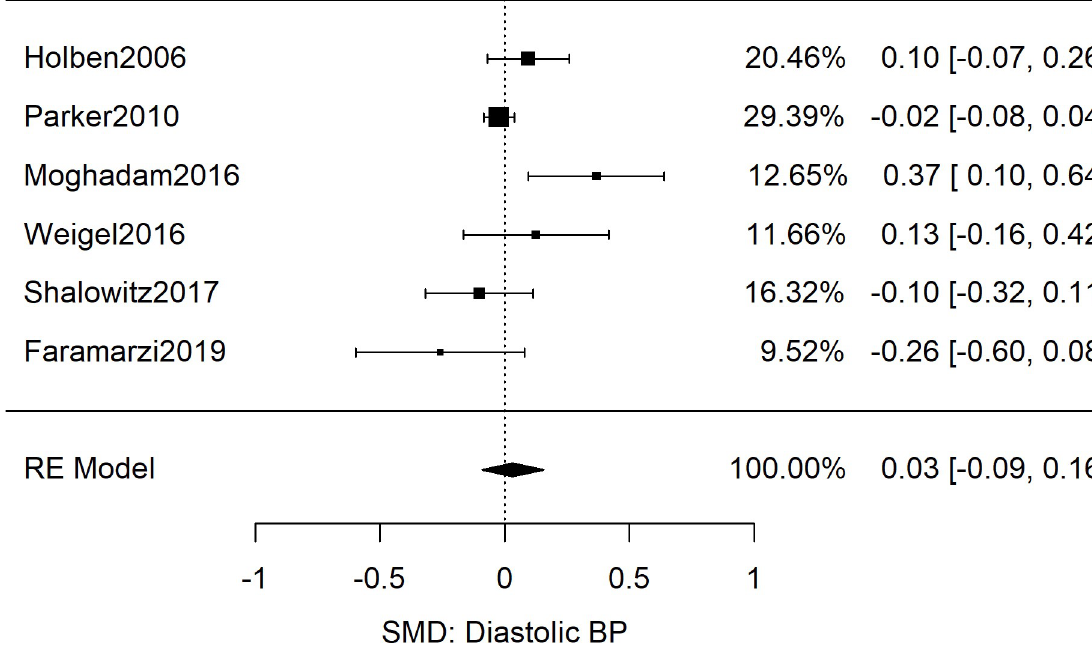
Fig 5. Meta-analysis of SMD of food insecurity and diastolic blood pressure in adults. Presented are the results from 6 studies reporting diastolic blood pressures as associated with food insecurity, resulting in a non-significant combined effect size ( g = 0.03 [95%CI: -0.09, 0.16; n = 15,240; Q ( df = 5) = 12.6; I 2 = 60%]).